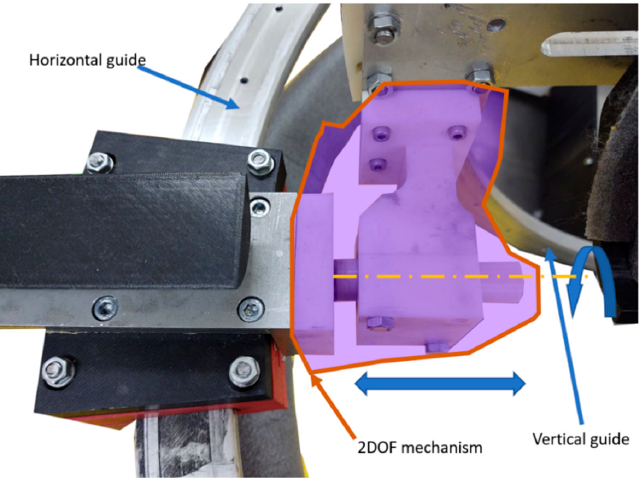
Figure 14. Two-Degrees of Freedom (DOF) mechanism between the circular guides.